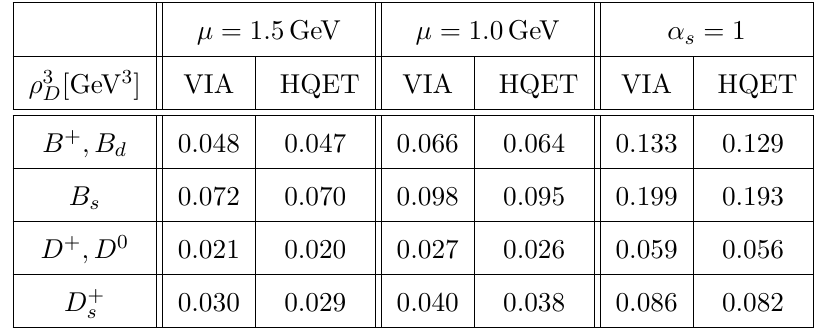
( H ) for B - and D -mesons in VIA and using HQET SR for Bag parameters Table 12 . Values of ρ 3 D for three different choices of α in eq. s